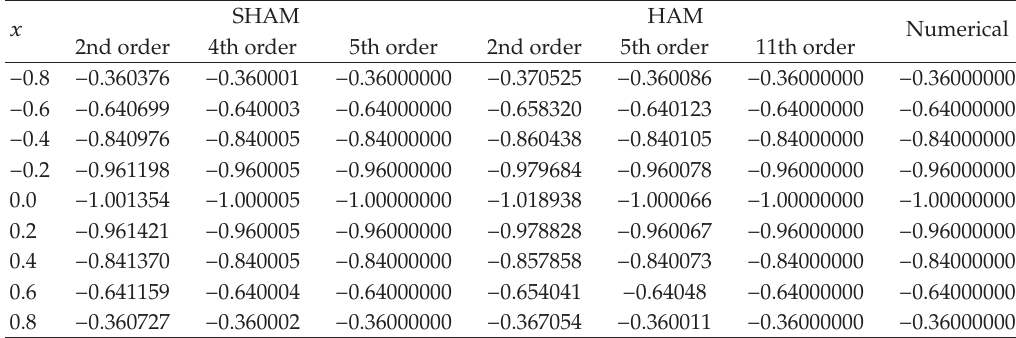
Table 1: Numerical result of Example 5.1 against the HAM and the SHAM solutions whit h (cid:8) − 0 . 85.